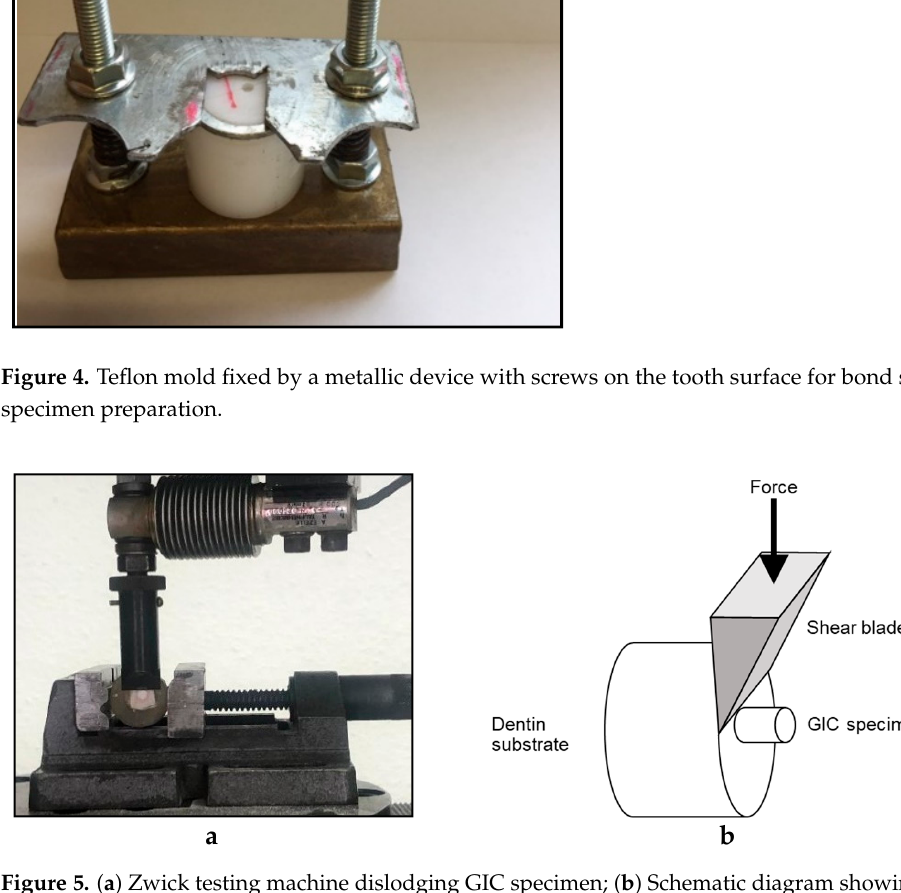
Figure 5. ( a ) Zwick testing machine dislodging GIC specimen; ( b ) Schematic diagram showing shear bond strength testing.